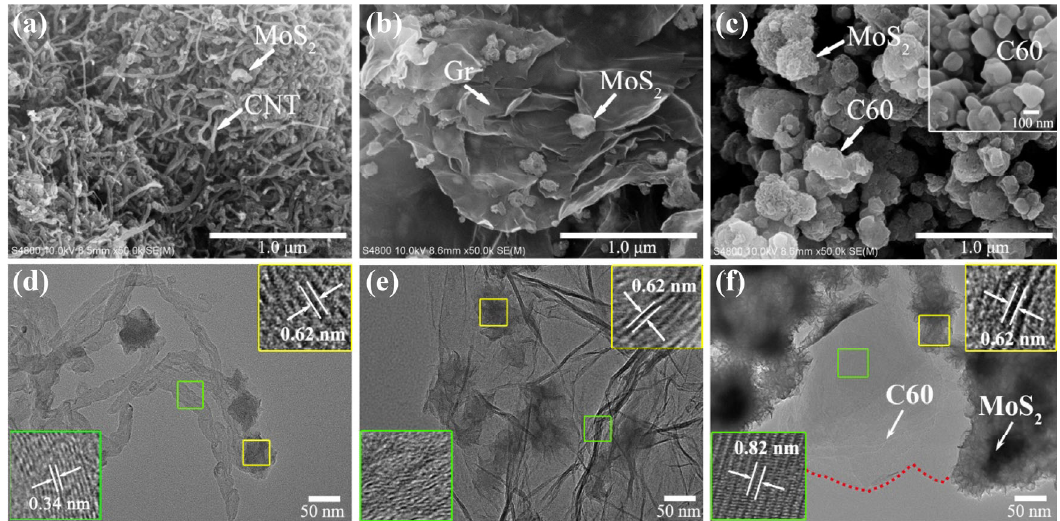
Fig. 1 Electron microscopy characterizations of MoS 2 @CNMs. FE-SEM images of (a) MoS 2 @CNT, (b) MoS 2 @Gr, and (c) MoS 2 @C60. Inset in (c) is the SEM image of pure C60. TEM images of (d) MoS 2 @CNT, (e) MoS 2 @Gr, and (f) MoS 2 @C60. Insets in (d–f) show the magnified images of some exposed edges of MoS 2 nanosheets (zoomed from the yellow contour) and the lattice spacing of CNT (zoomed from the green